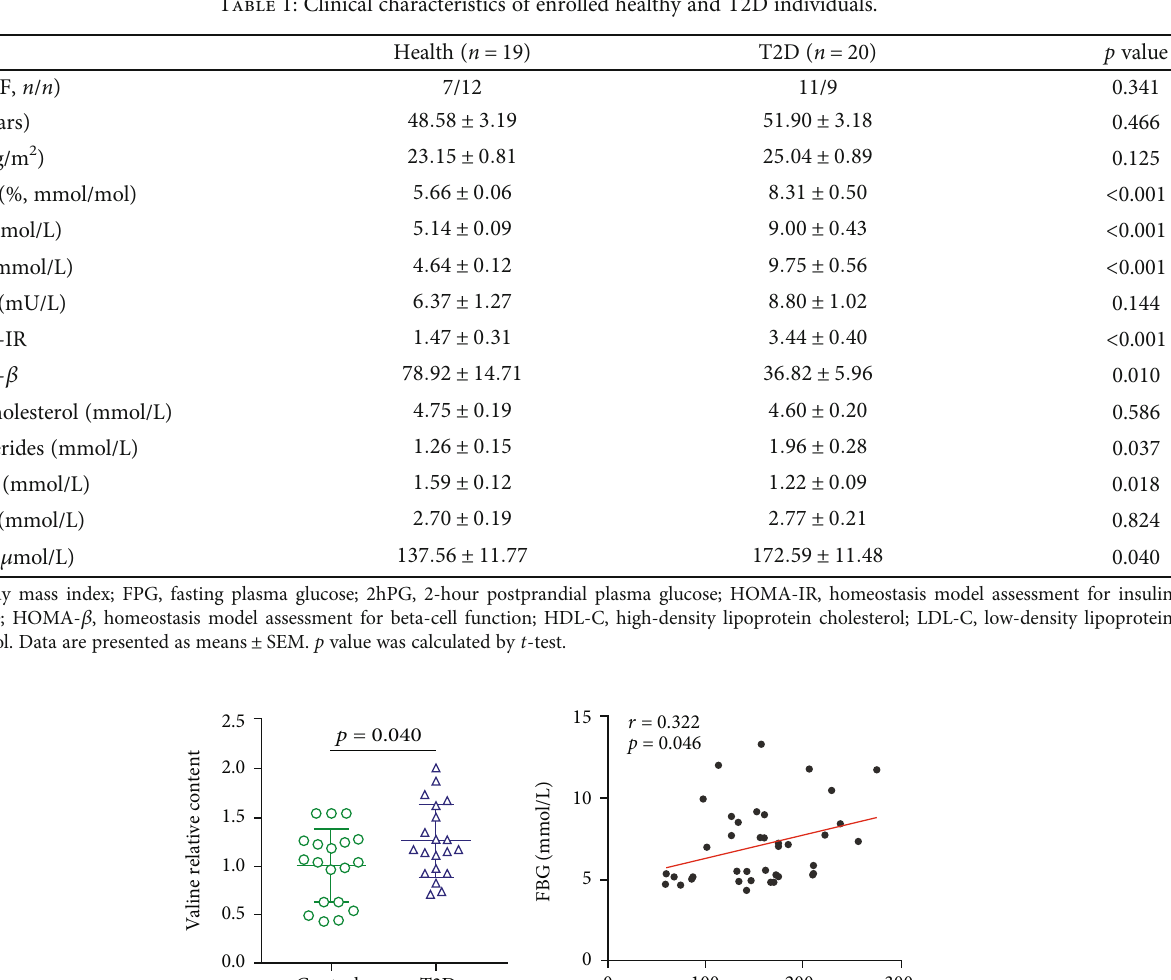
Table 1: Clinical characteristics of enrolled healthy and T2D individuals.